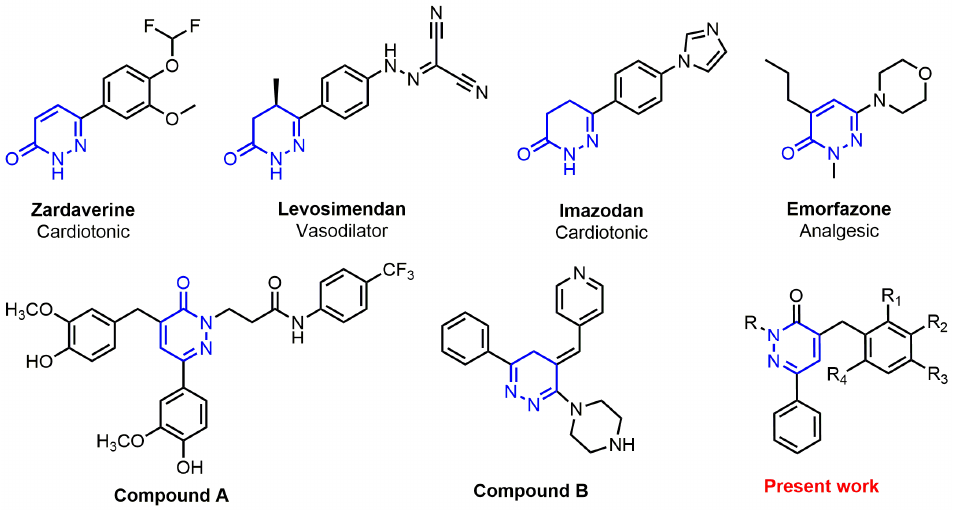
Figure 1. Representative examples of biologically active drugs containing pyridazine moiety.